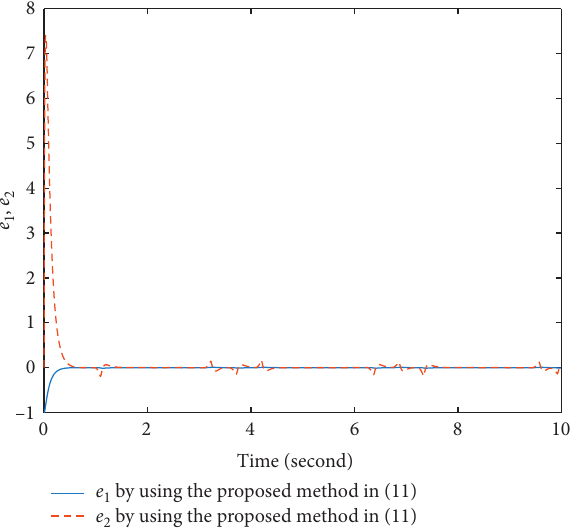
Figure 5: Trajectories of e (11).